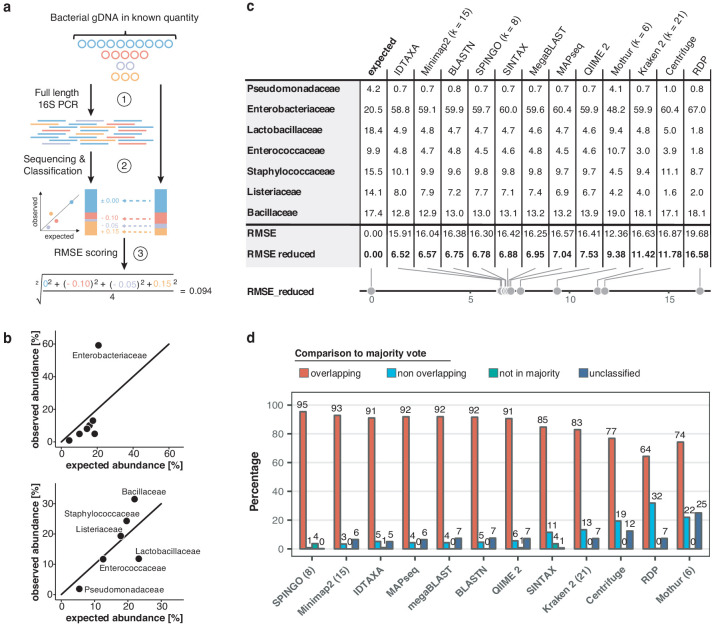
Benchmarking of classification tools with nanopore full-length 16S sequences.(a) Schematic of mock community quantification performance testing. (b) Observed vs. expected read fraction of bacterial families present in 10,000 nanopore reads randomly drawn from mock community sequencing data. Example representation of Minimap2 (kmer length 15) quantifications with (upper) and without (lower) Enterobacteriaceae (Materials and methods). (c) Mock community classification output summary for twelve classification tools tested against the same 10,000 reads. Root mean squared errors observed and expected bacterial read fractions are provided with (RMSE) and without Enterobacteriaceae (RMSE reduced). (d) Classification output summary for 10,000 reads randomly drawn from an example freshwater sample (Materials and methods). ‘Overlapping’ fractions (red) represent agreements of a classification tool with the majority of tested methods on the same reads, while ‘non-overlapping’ fractions (light blue) represent disagreements. Dark green sets highlight rare taxon assignments not featured in any of the 10,000 majority classifications, while dark blue bars show unclassified read fractions.